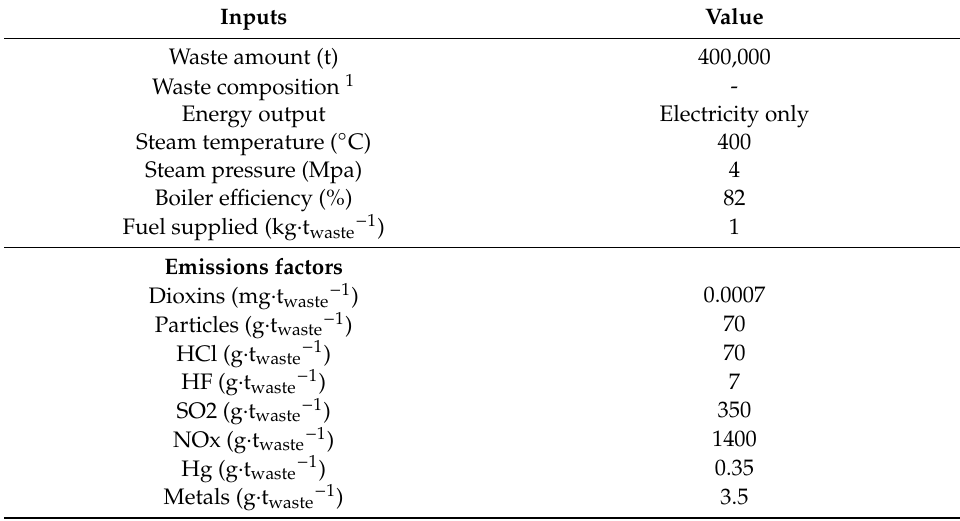
Table 6. Inputs to the WTE